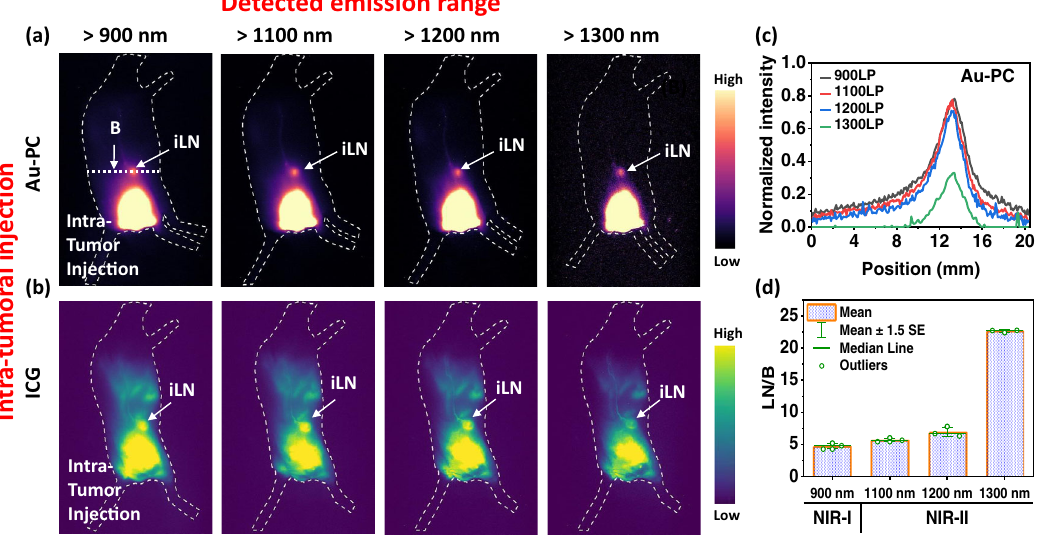
Fig.6|LymphnodeimaginginvariousNIRsubwindows. Wide- fi eld fl uorescence images (excited by an 808nm laser at a power density of 70mW/cm 2 ) of intra- tumoral (i.t.)injected a 1x Au-PC conjugate and b ICG probes into a mouse bearing 4T1 tumor (six weeks old female Balb/c, n =3). The images present the right lateral view taken 30min p.i and 3h p.i for Au-PC and ICG respectively at different NIR-I and NIR-II windows. The exposure times for detecting >900nm, >1100nm, >1200nmand>1300nmemissionwere25ms,20ms,90msand400msforAu-PC